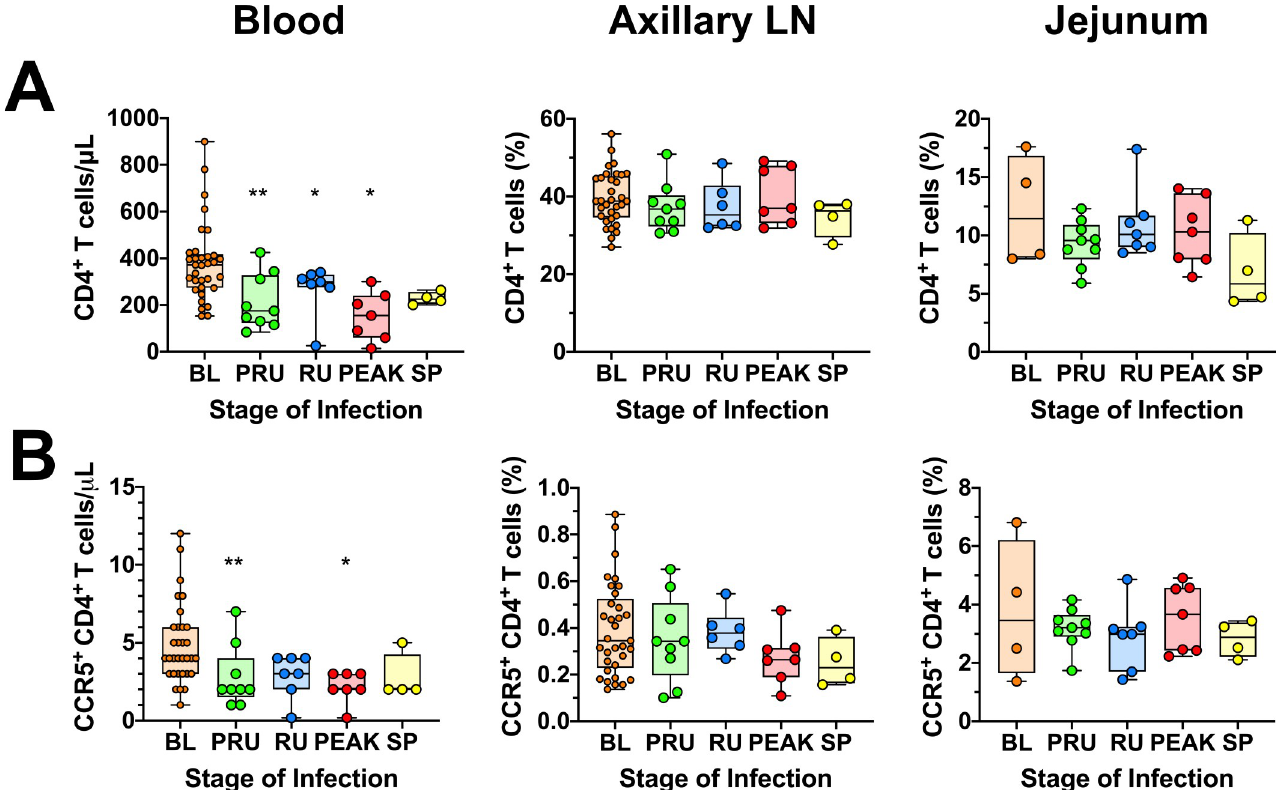
Fig 2. CD4 + and CCR5-expressing CD4 + T-cell in the blood, jejunum and lymph nodes of SIVsab-infected AGMs. Total populations of (A) CD4 + T cells; (B) CCR5 + CD4 + T cells isolated from blood, axillary LN and jejunum. The values for blood represent absolute cell counts, while the values in the jejunum and axillary LN represent percent populations. The five groups are based on the days postinfection, with: BL (baseline, preinfection, orange), PRU (preramp, 1–3 dpi, green) RU (ramp-up, 4–6 dpi, blue), PEAK (peak, 9-12dpi, red) and SP (set-point, 46–55 dpi, yellow). Asterisks indicates statistical significance when compared to baseline values, with � = p < 0 . 05 ; �� = p < 0 . 01